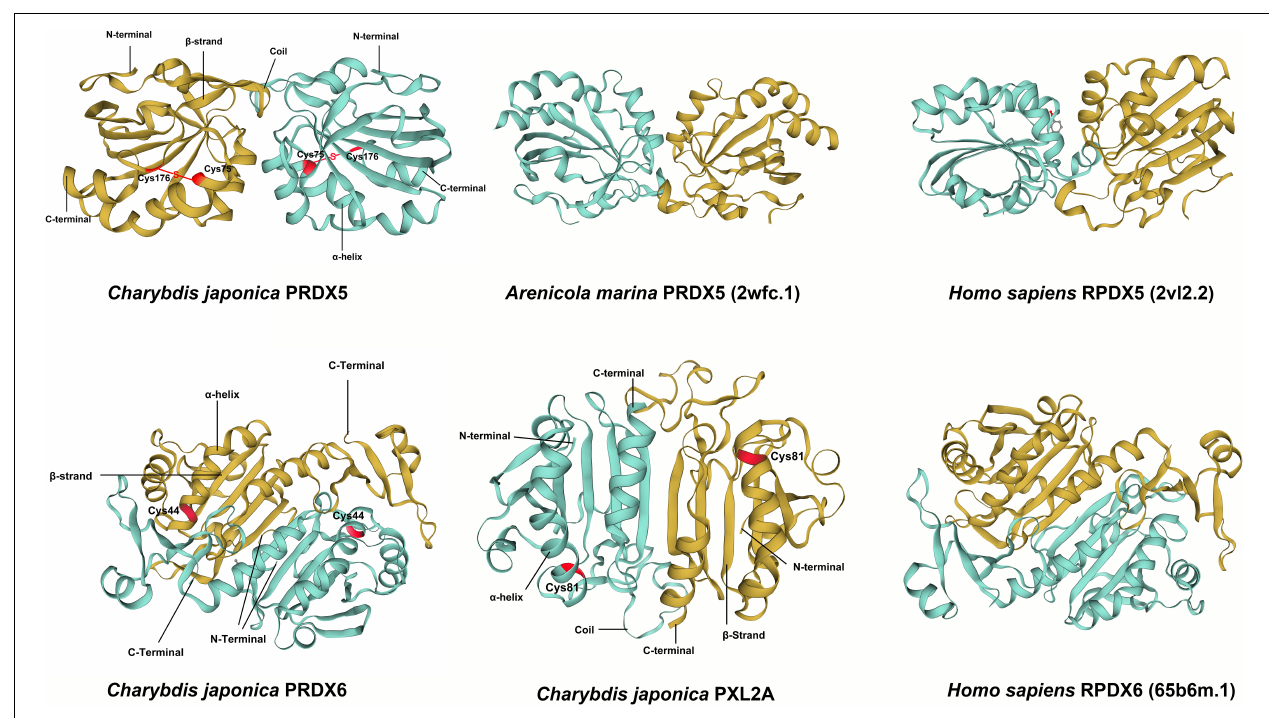
FIGURE 5 | The predicted spatial structures of C. japonica PRDX5, C. japonica PRDX6, C. japonica PXL2A, Arenicola marina PRDX5, Homo sapiens PRDX6, and Homo sapiens